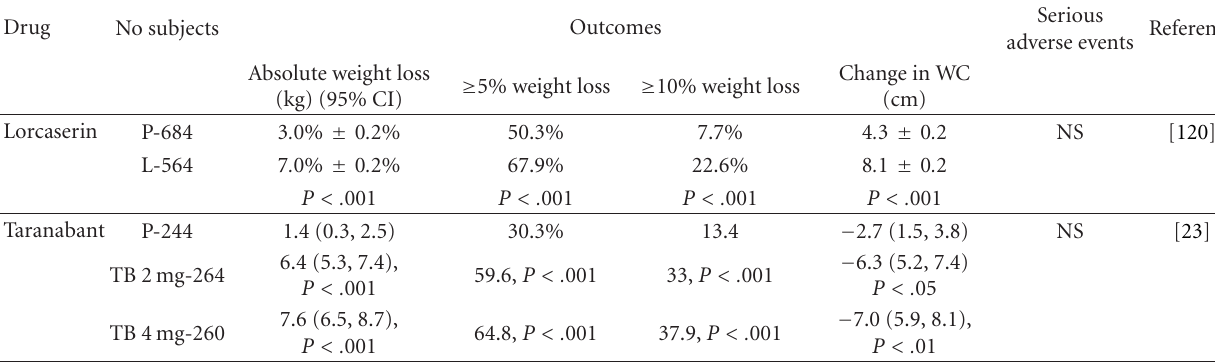
Table 6: Recent randomised controlled trials of weight loss therapies with 2-years followup.